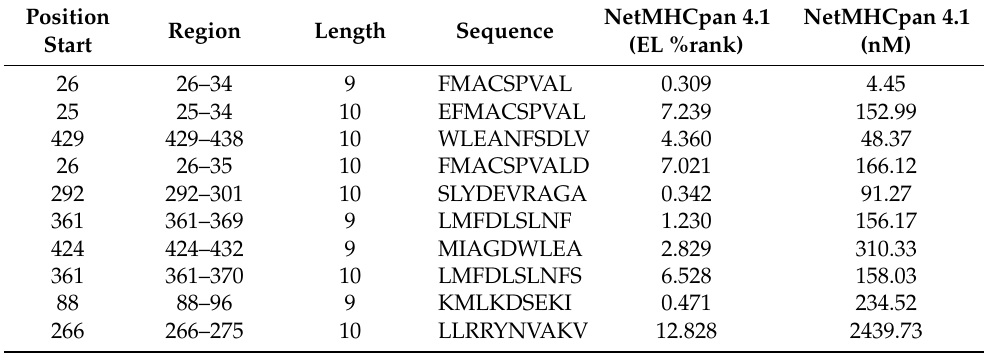
Table 4. HLA-A*0201-binding peptides derived from SOX-11 as defined by NetMHCpan 4.1.